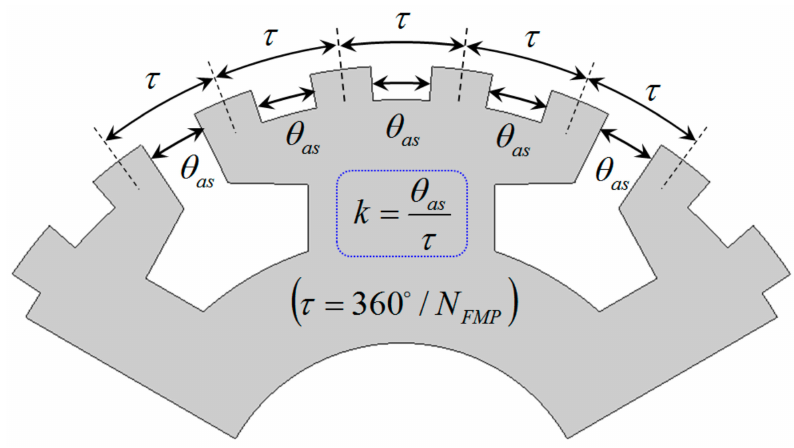
Figure 6. FMP pitch and the width of the auxiliary slots including the slot openings.